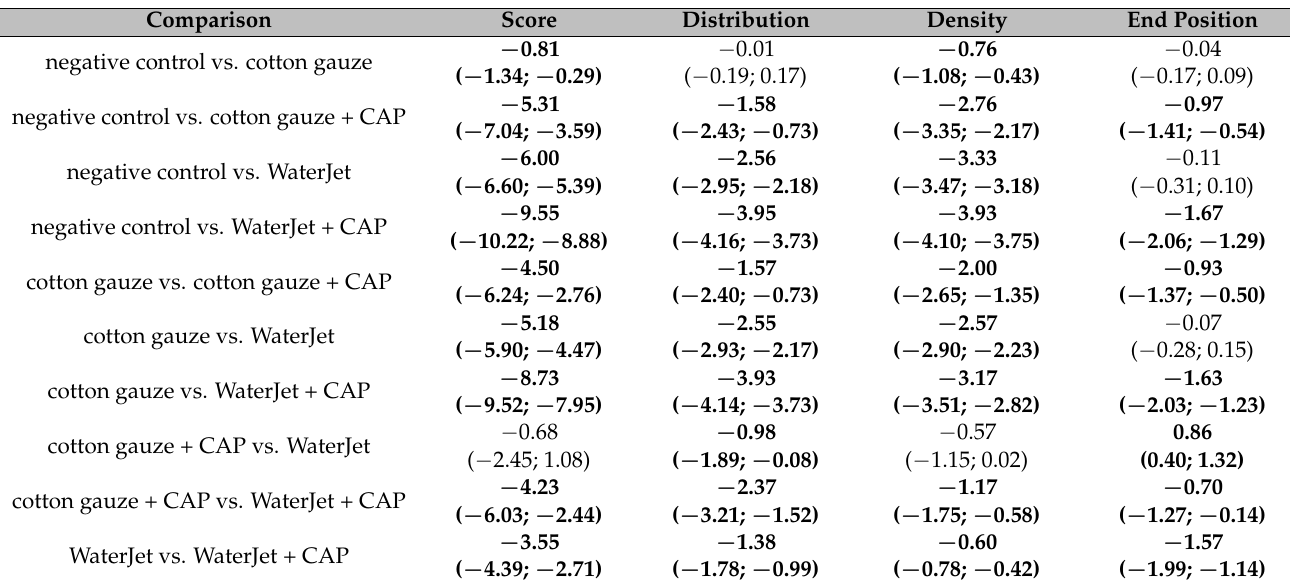
Table A2. Pairwise comparisons between groups (using lincom) after performing the linear regression models for associations of treatment group on all four outcomes of the bacterial agar growth analysis statistics. Beta coefficients and 95% confidence intervals are reported. Bold numbers indicate statistically significant effects ( p -value <